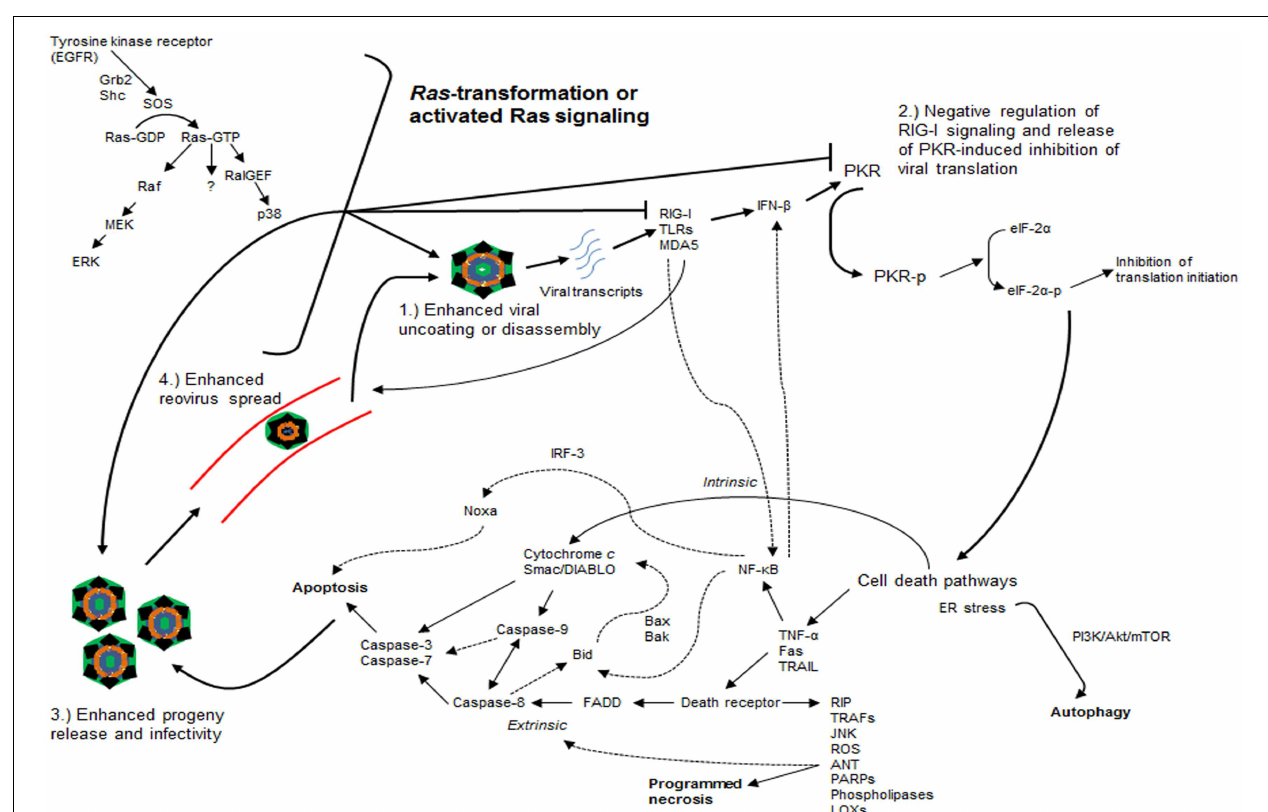
(LOXs). Apoptosis occurs through both extrinsic [e.g.,TRAIL binding to cell surface death receptor recruits Fas-associated death domain (FADD), which recruits and activates the initiator caspase-8 that ultimately activates effector caspases-3 and -7] and intrinsic pathways [cytochrome c